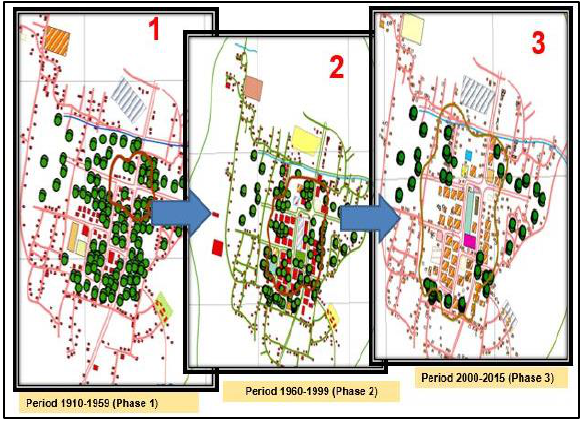
Figure 5. Comparison of the land use for the three transformation periods of the Ijebu-jesa built